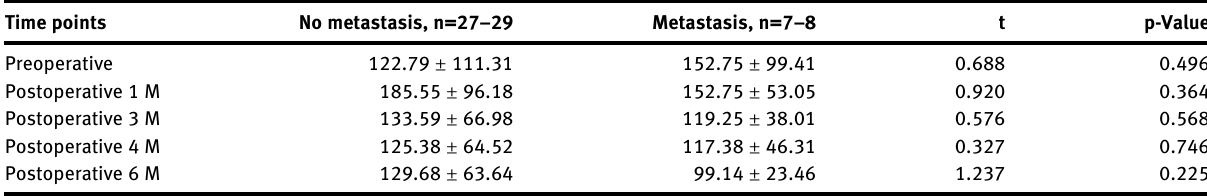
Table  : Association between platelet levels and postoperative metastasis. Time points